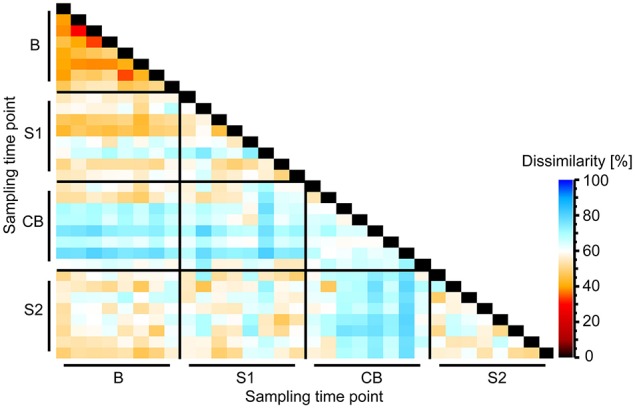
Heatmap showing Bray-Curtis dissimilarity between bacterial epimural communities between different sampling time points B (baseline), S1 (SARA 1), CB (challenge break), and S2 (SARA 2).